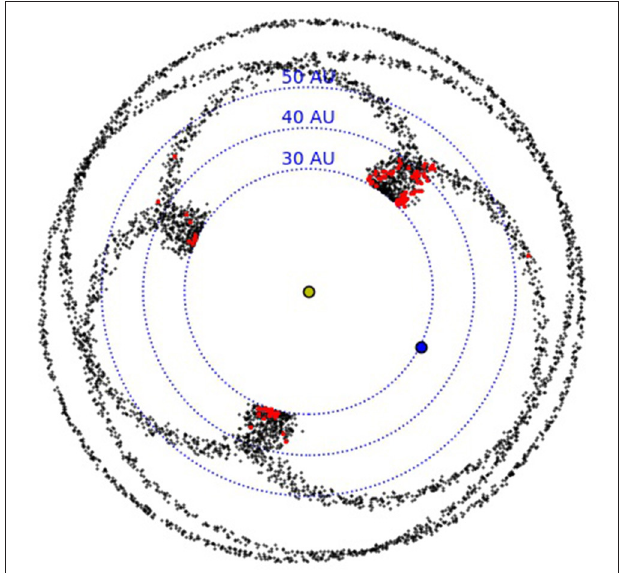
FIGURE 2 | Black points show the positions of TNOs in a snapshot from this parametric toy model of TNOs in the 2:1 mean-motion resonance. The position of Neptune is shown by a blue circle, and dotted circles show distances from the Sun. Red points show simulated detections after running this model through the Survey Simulator. One third of the TNOs are in each libration island in the intrinsic model, but 2/3 of the detections are in the leading asymmetric island (having pericenters in the upper right quadrant of this plot). This bias is simply due to the longitudinal direction of pointings within the OSSOS ensemble and pericenter locations in this toy model of the 2:1